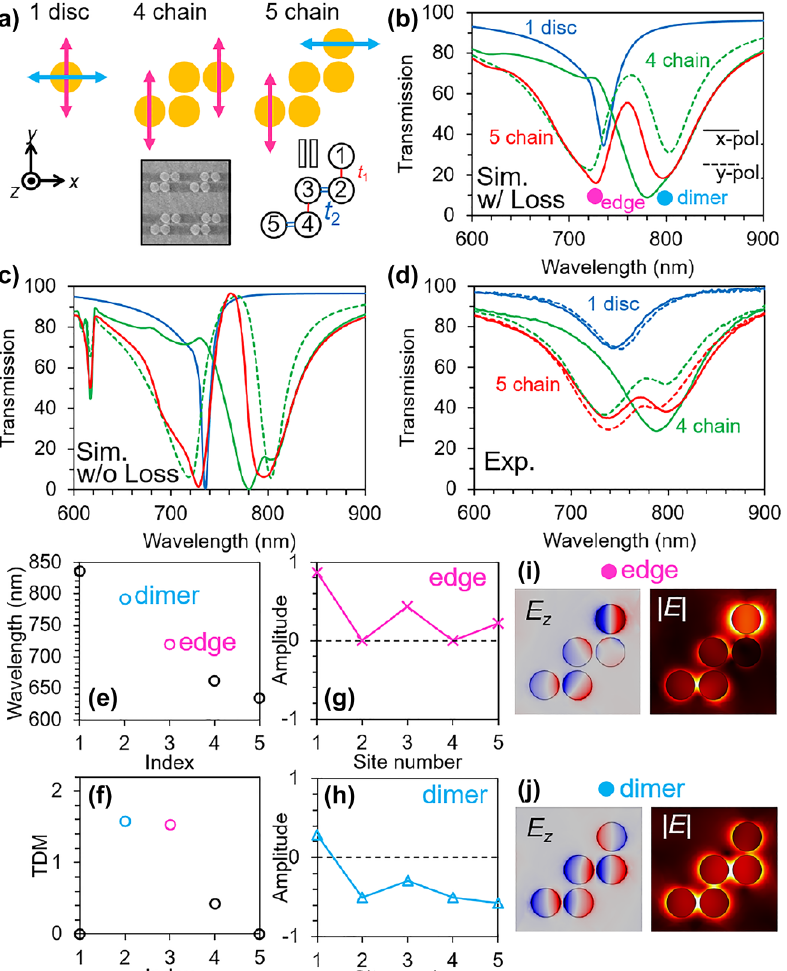
Figure 2: Experimental and numerical analy- sis on the relatively short chains. (a) Schematics of the 1, 4, and 5 chains